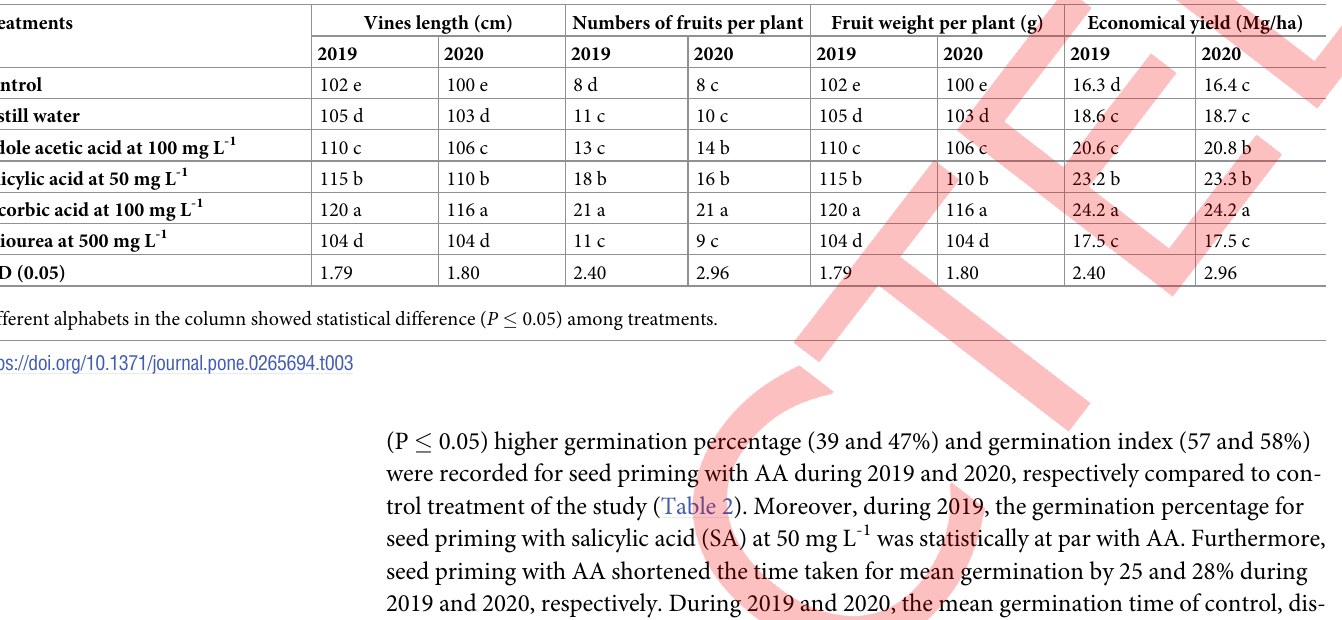
Table 3. The influence of seed priming with different growth regulators on vine length, number of fruits and fruit weight per plant and economic yield of Indian squash under field conditions. Treatments Vines length (cm)